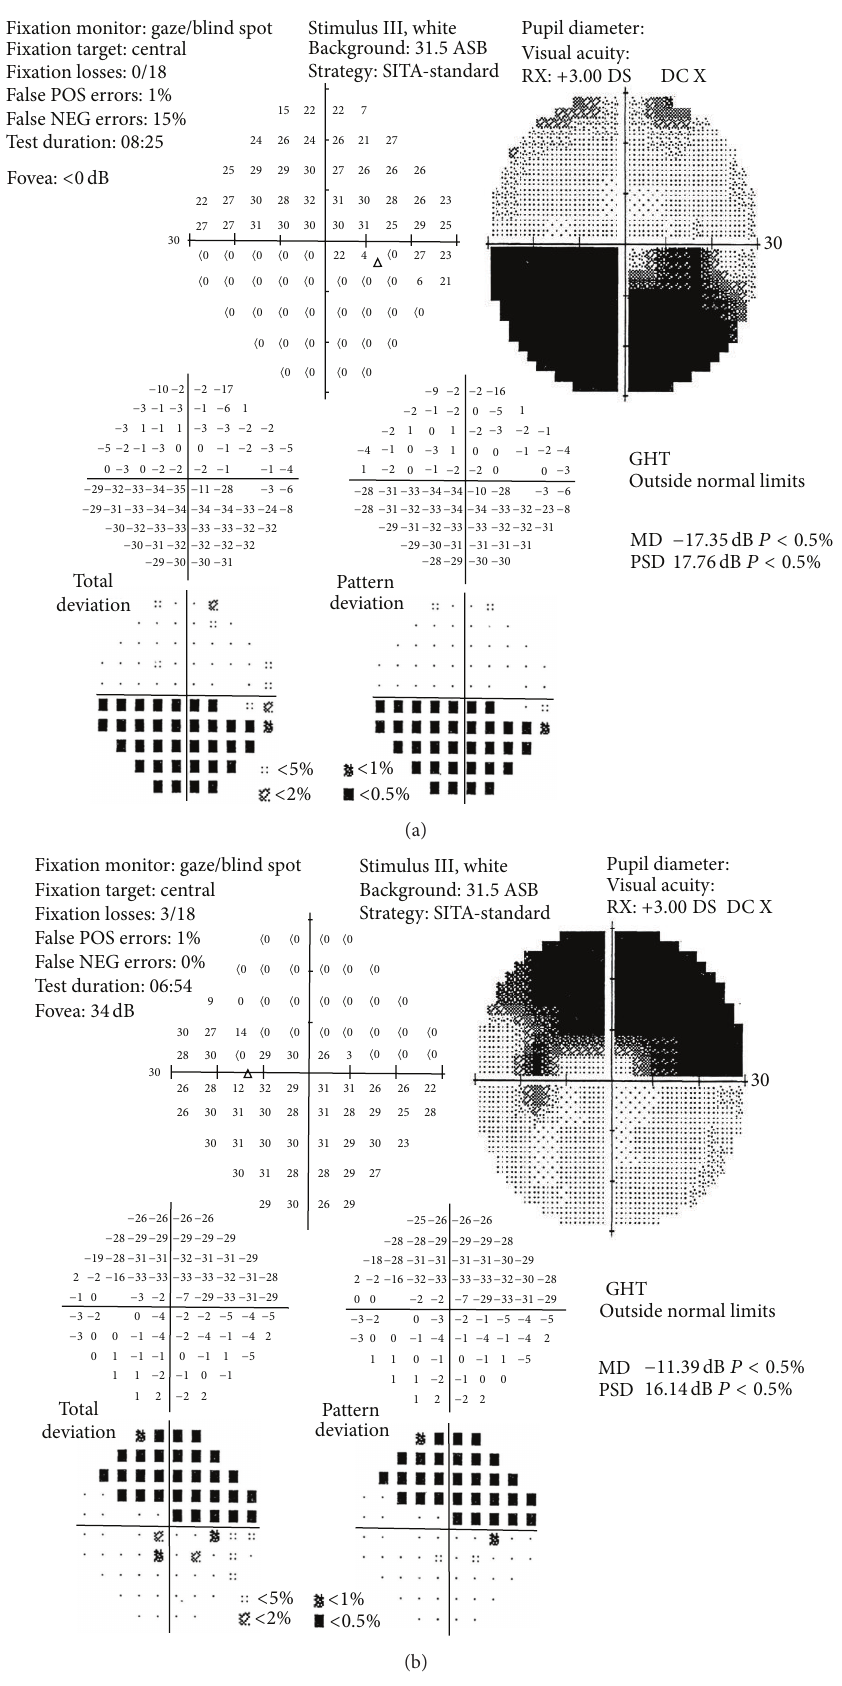
Figure 2: Humphrey visual field. (a) Right eye, (b) left